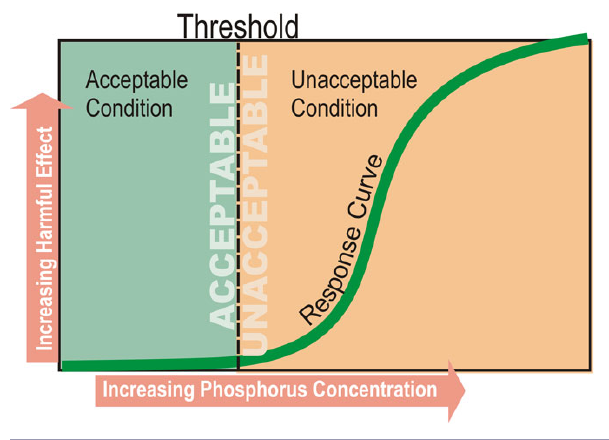
Fig. 1. Threshold